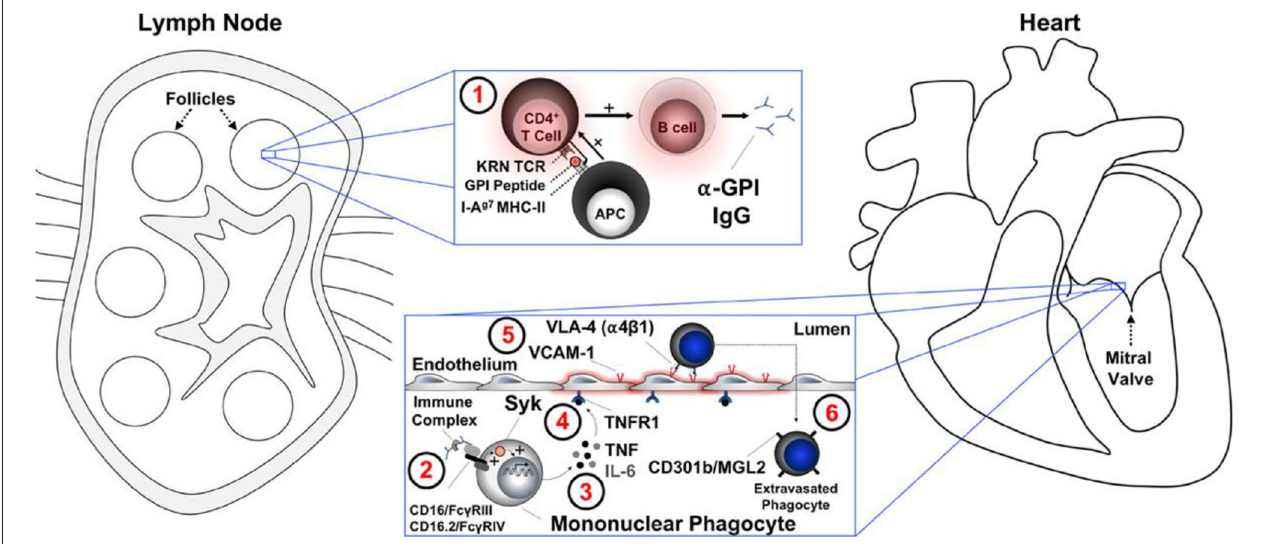
FIGURE 7 | A summary working model for the initiation of cardiac valve inflammation and fibrosis in K/B.g7 mice. Anti–glucose-6-phosphate isomerase ( α -GPI) IgG autoantibodies produced systemically in the secondary lymphoid tissue (spleen and lymph nodes) (1) activate valve-infiltrating mononuclear phagocytes (MNPs) in a spleen tyrosine kinase (Syk)–dependent process (2) resulting in local production of TNF and IL-6 from CX3CR1 + CD301b/MGL2 + MNPs. Tumor necrosis factor (TNF) receptor − 1 (TNFR1)–mediated activation of the valve stroma (3) promotes vascular cell adhesion molecule − 1 (VCAM-1) upregulation (4) and subsequent recruitment of additional circulating CX3CR1 + MNPs via very late antigen − 4 (VLA-4, α 4 β 1 integrin) in a feed-forward process (5). Interstitial MNPs assume a tissue-reparative phenotype characterized by expression of CD301b/MGL2, resistin-like molecule- α , and arginase-1 (6). APC indicates antigen-presenting cell (e.g., dendritic cell);